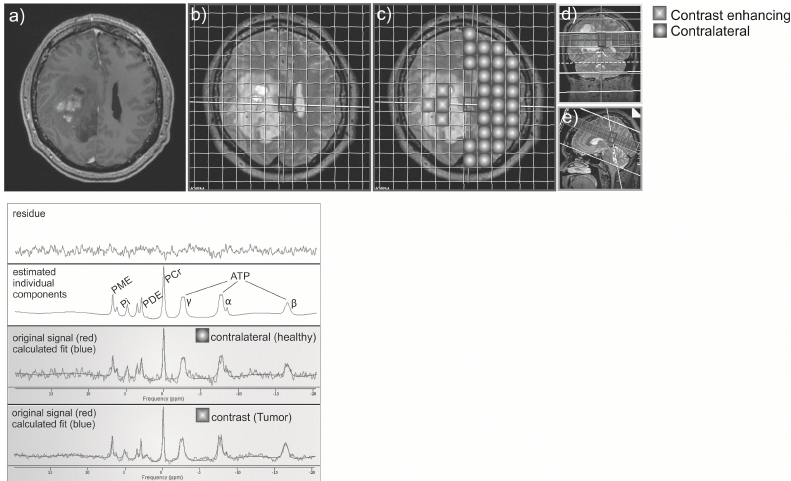
Figure 1. Contrast-enhanced T1 axial image ( a ) was registered to the spectroscopy-grid ( b ), and two regions: contrast-enhancing or tumor region, and contralateral “healthy” region were chosen ( c ). Correct position of voxels was checked on coronal ( d ) and sagittal ( e ) T2 images. Spectroscopy curve was depicted for each voxel ( below